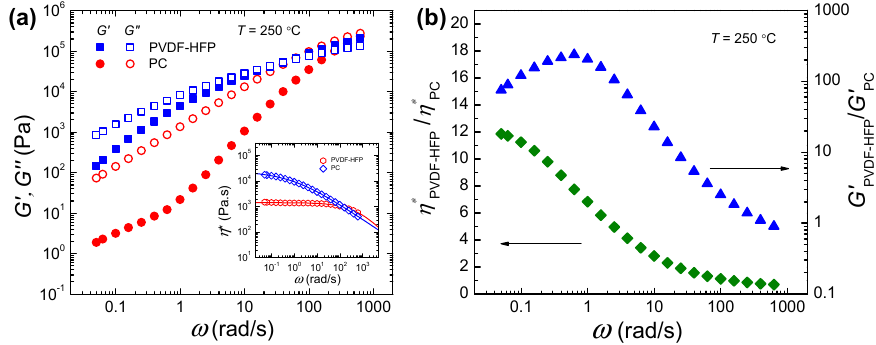
Figure 2. ( a ) Comparison of storage modulus ( G ′ ) and loss modulus ( G ″ ) against angular frequency for PVDF-HFP and PC at 250 ◦ C. The inset in ( a ) shows the complex viscosity versus frequency. ( b ) Viscosity and elasticity ratios of PVDF-HFP to PC against angular frequency at 250 ◦